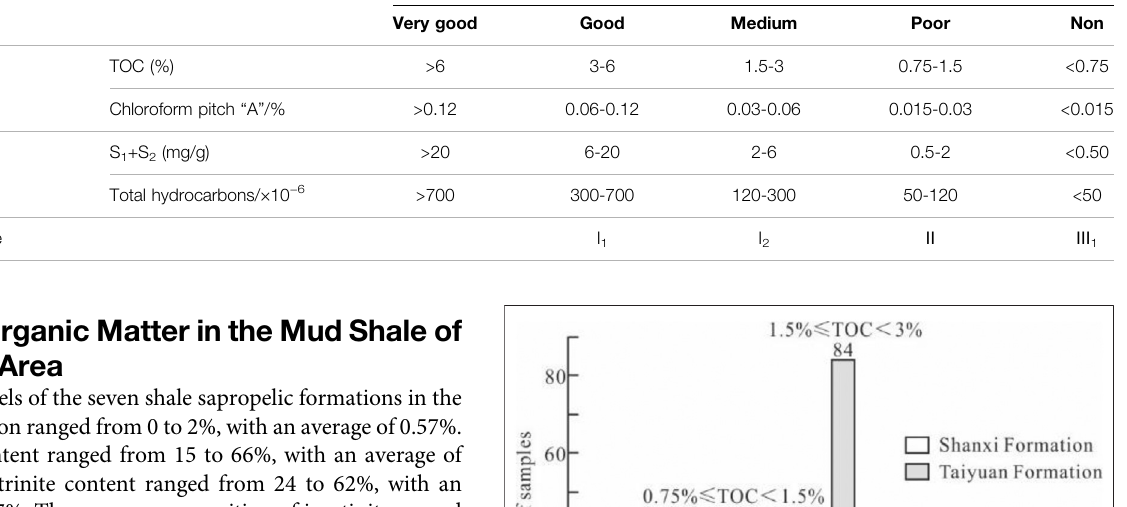
TABLE 1 | Evaluation criteria for the abundance of organic matter in coal-measure source rock of sea and land interactions (Chen et al., 1997). Oil source rock type